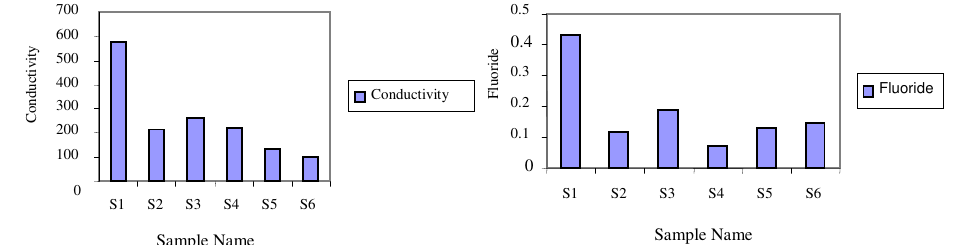
Figure 5. EC value of various sample Figure 6. Fluoride in various